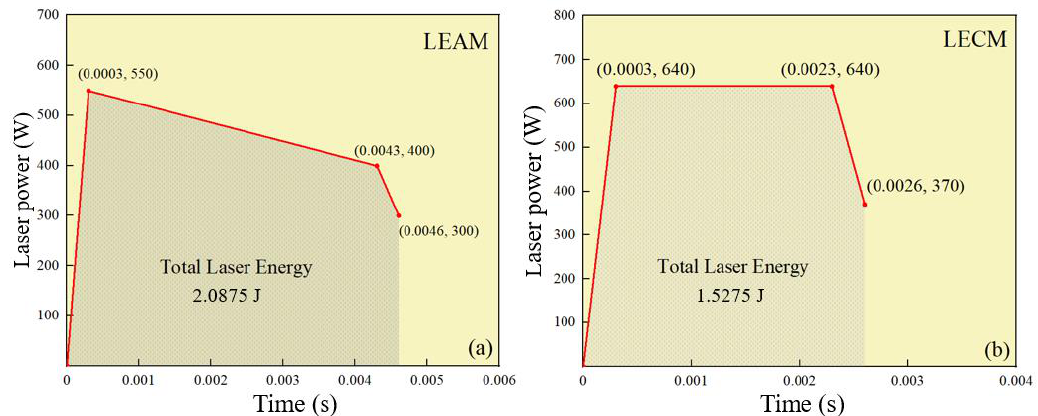
Figure 2. Different pulse waveforms. ( a ) Laser energy attenuation mode (LEAM). ( b ) Laser energy continuous mode (LECM).